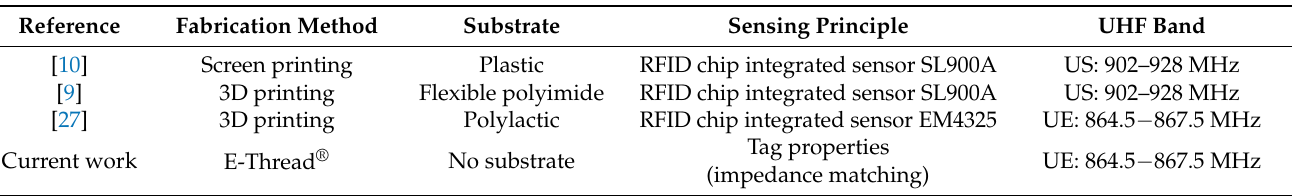
Table 2. Comparison between the properties of the UHF RFID temperature sensor tag integrated in a textile yarn with solutions existing in the literature.